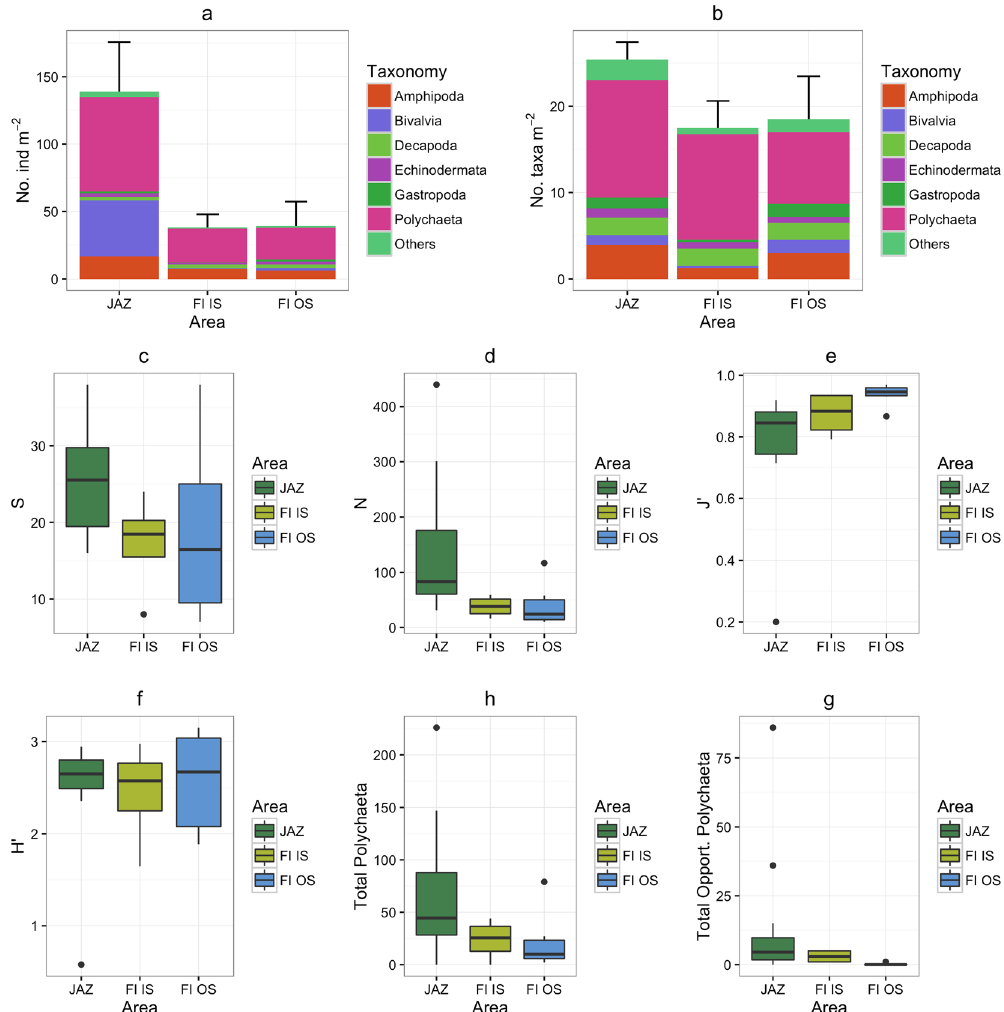
areas ( b ). Boxplots for the univariate variables number of taxa (S, taxa × 0.1 m 2 ) ( c ), abundance (N, no. of individuals × 0.1 m 2 ) ( d ), Pielou’s equitability (J’) ( e ) and Shannon-Wiener diversity (H’) ( f ), the total number of Polychaeta ( h ) and the total number of opportunistic Polychaeta ( g ) based on soft sediment macrofauna in the different areas. JAZ, Jazan; FI IS, Farasan Islands-Inner shelf; FI OS, Farasan Islands-Outer